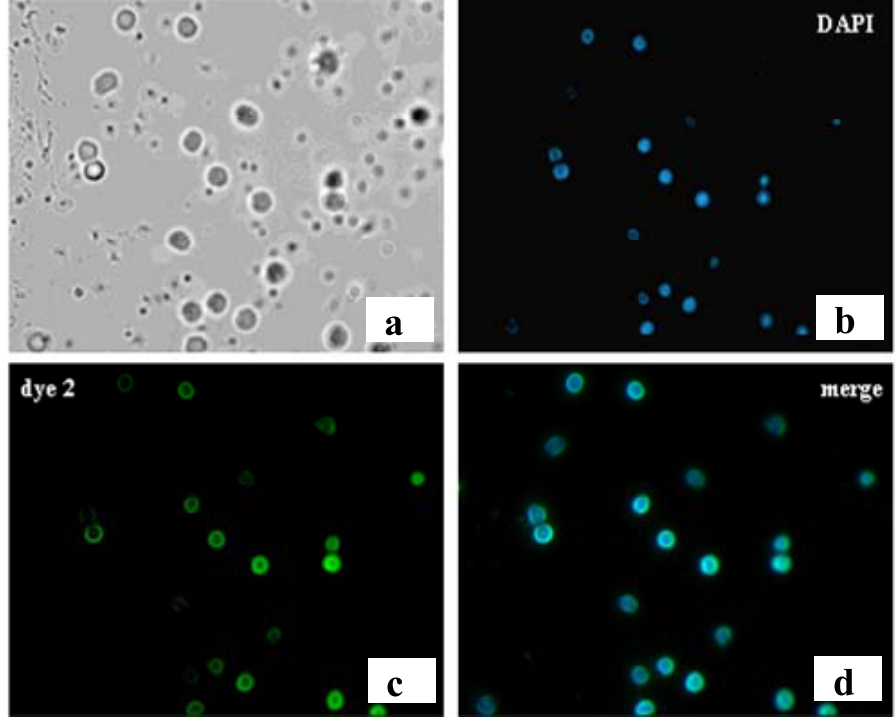
Figure 11. T lymphocytes from a fresh blood sample of a healthy volunteer stained using anti-CD4 mAb labeled with Eterneon TM 384/480 NHS. ( a ) Light transmission image; ( b ) Nuclear staining with DAPI; ( c ) Fluorescent localization of the anti-CD4 labeled with dye 2 showing that the fluorophore is localized exclusively in the membrane of approximately the 50% of the cells, without entering in the cytosol; ( d ) Merge image ( b + c ) showing nuclear and membrane staining. Magnification: 40×.